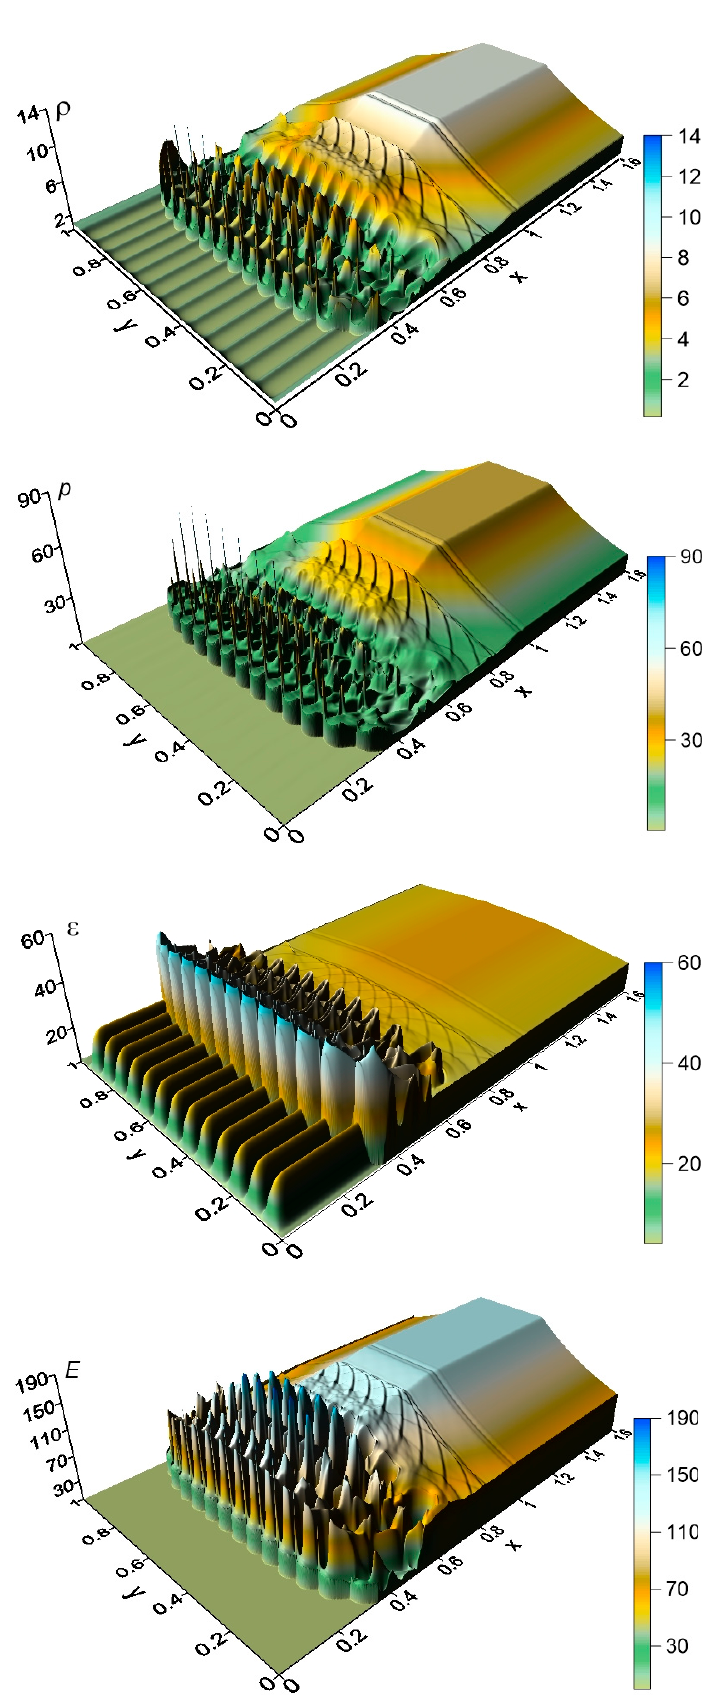
Figure 6. Fields of the considered parameters ( ρ , p , ε and E ): M = 6, α = 0.1, t = 0.15 .